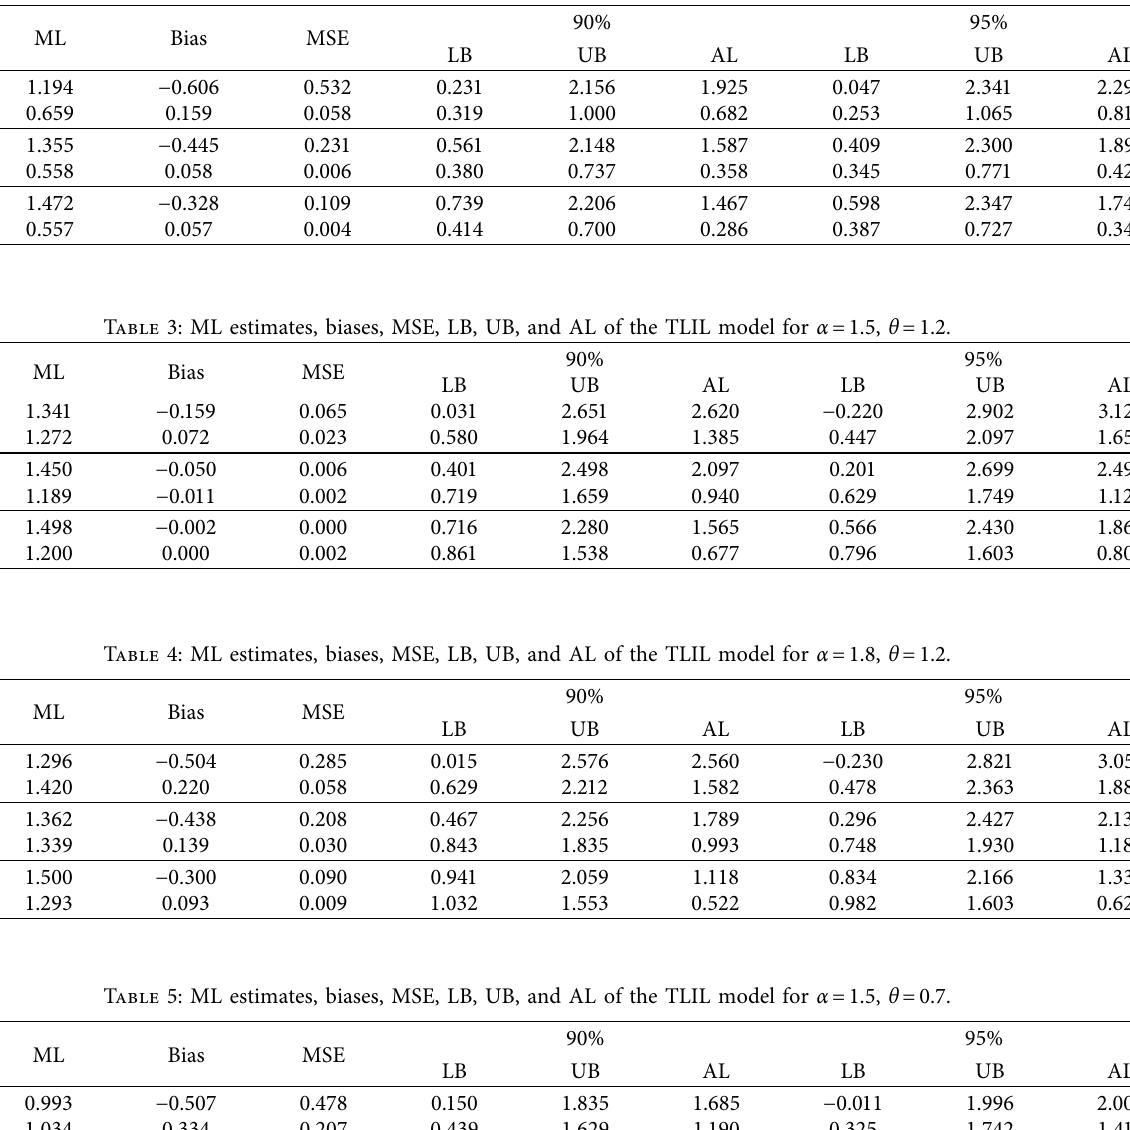
Table 2: ML estimates, biases, MSE, LB, UB, and AL of the TLIL model for α � 1.8, θ � 0.5.